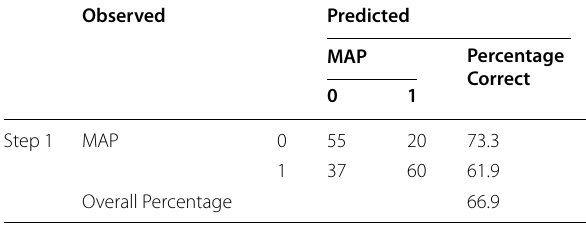
Table W. Classification table for attention to details culture Observed